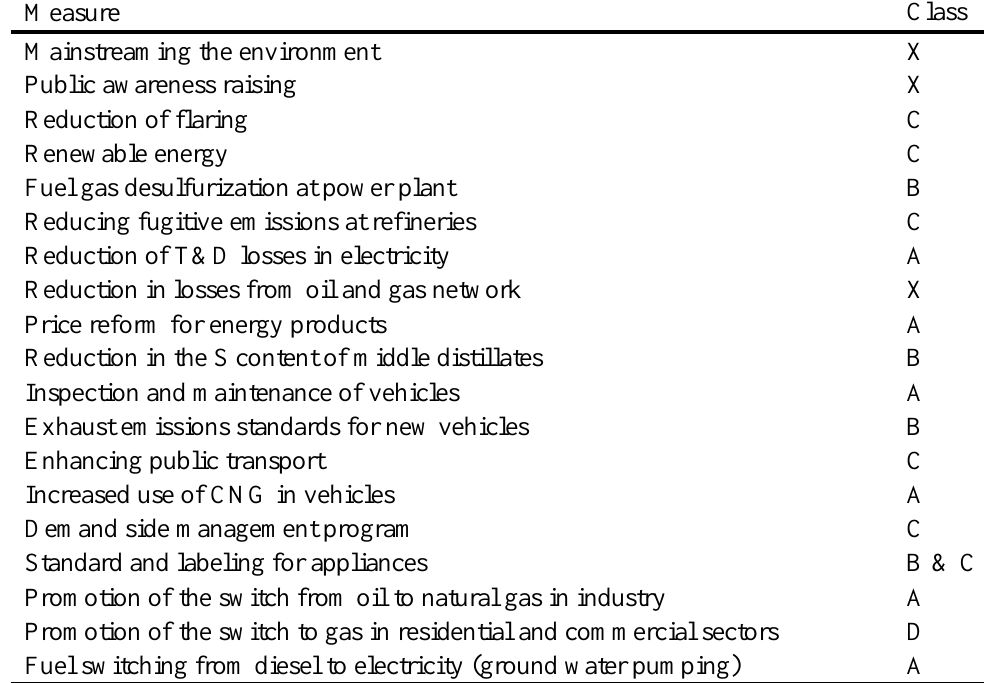
Table 6. Summary of Cost Benefit Analysis (CBA)